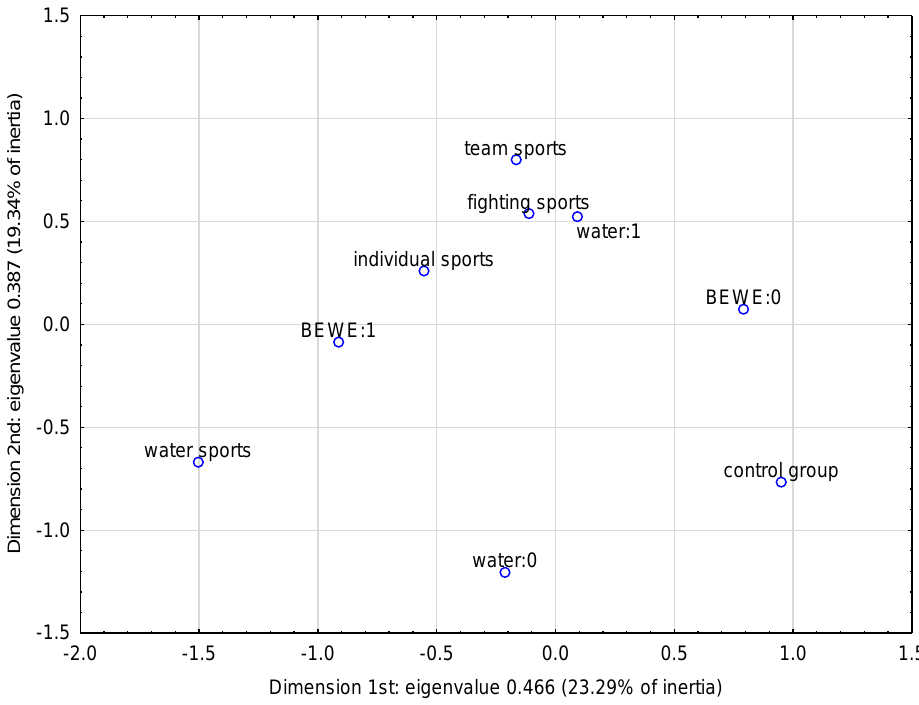
Figure 6. Multidimensional correspondence analysis—2-dimensional plot. Table 4. Multidimensional correspondence analysis—parameters of determined points.